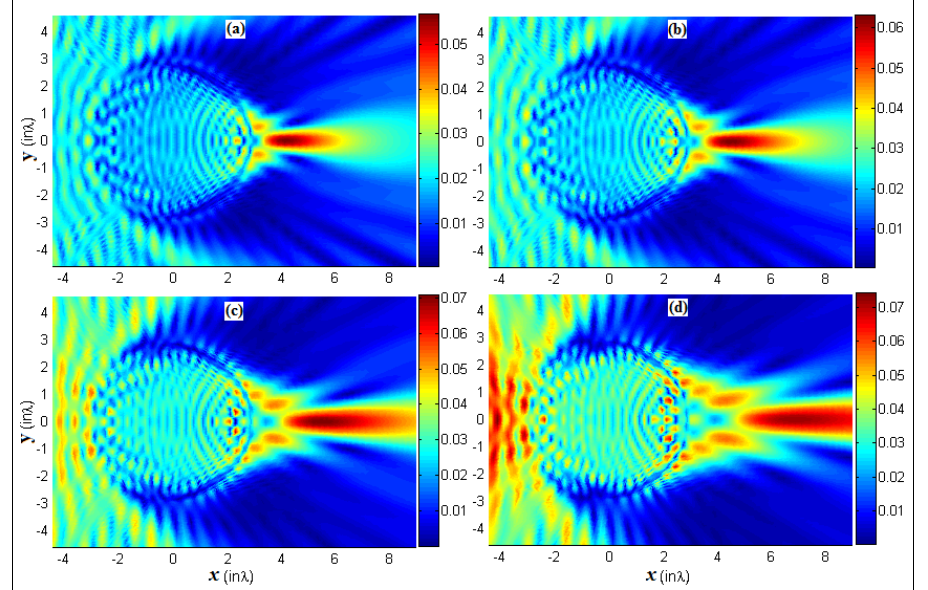
Figure 3. Illumination by a point-source placed at different positions from a cylinder whose ( R , n ) = (3 λ ,1.5): ( a ) d = 15 λ , ( b ) d = 10 λ , ( c ) d = 5 λ , and ( d ) d = 3 λ . (The colormap